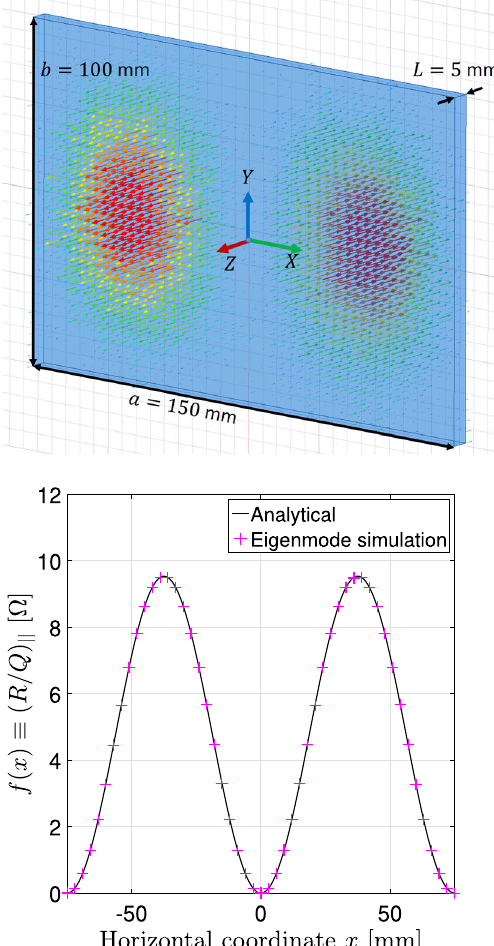
FIG. 1. An illustrative example of eigenmode data for a slightly asymmetric cavity. The fit window around the point of interest x 0 contains 7 data points (the purple line with the error bars). The value of f falls below its error bar inside the fit window, and the tangent constraint is enforced to the fitting parabola (the blue line).